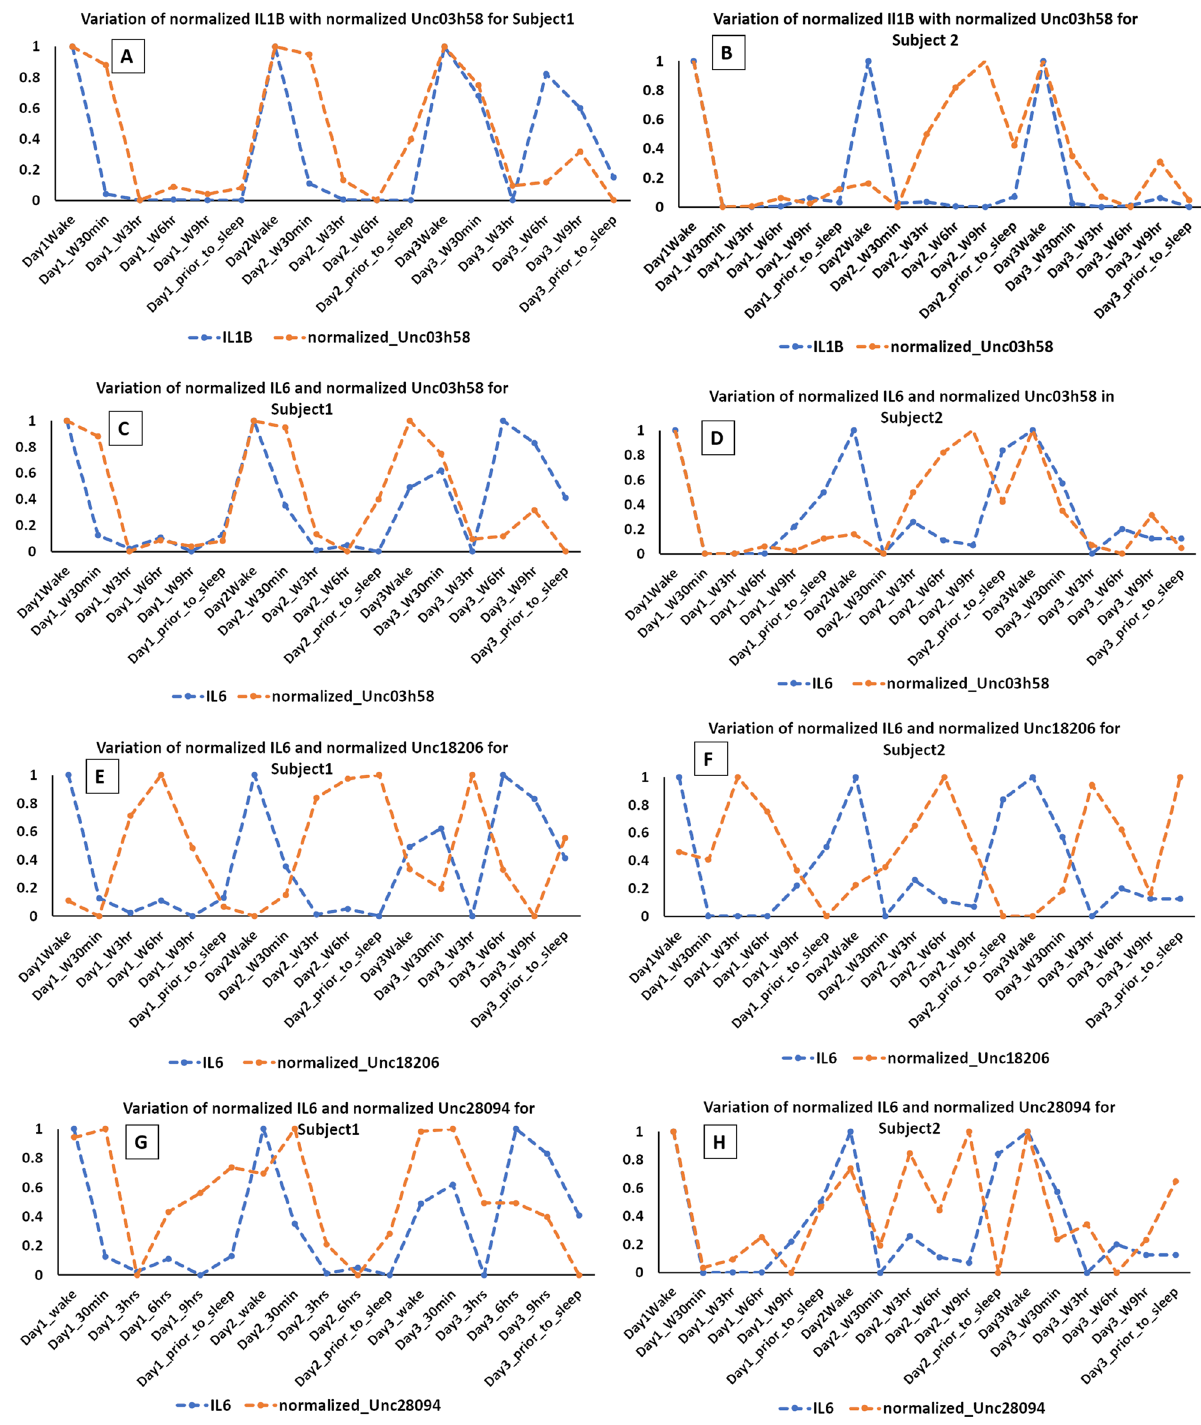
Figure 9. Plots showing association of OTU and normalized cytokine level in two subjects over three days. Figures for Subjects 1 and 2, respectively: ( A , B ) Positive correlation and periodicity between IL-1β and Unc03h58 ( Prevotella ), ( C , D ) Positive correlation and periodicity between IL6 and Unc03h58 ( Prevotella ), ( E , F ) Negative correlation and periodicity between IL6 and Unc18206 ( Neisseria ), ( G , H ) Positive correlation and periodicity between IL6 and Unc28094 ( Porphyromonas